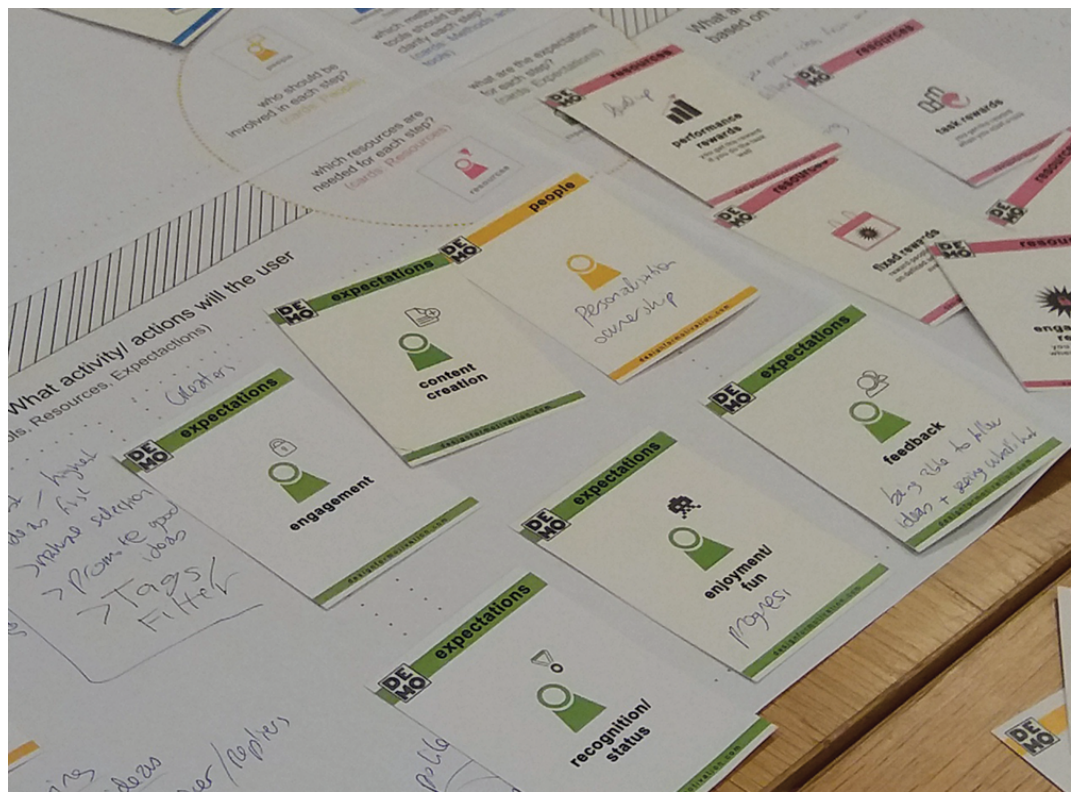
Figure 1. The DEMO cards positioned on the